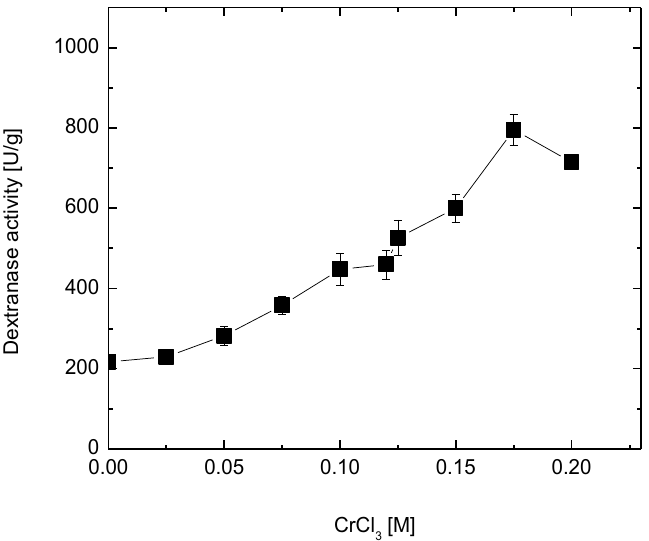
Figure 6. Effect of different concentrations of Chromium chloride on dextranase production from Bacillus subtilis NRC-B233b